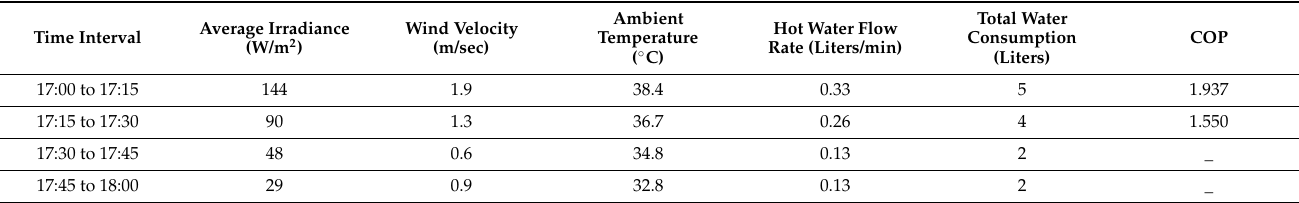
Table 8. Total water consumption—13 L (Electricity consumption—0.3 kWh).